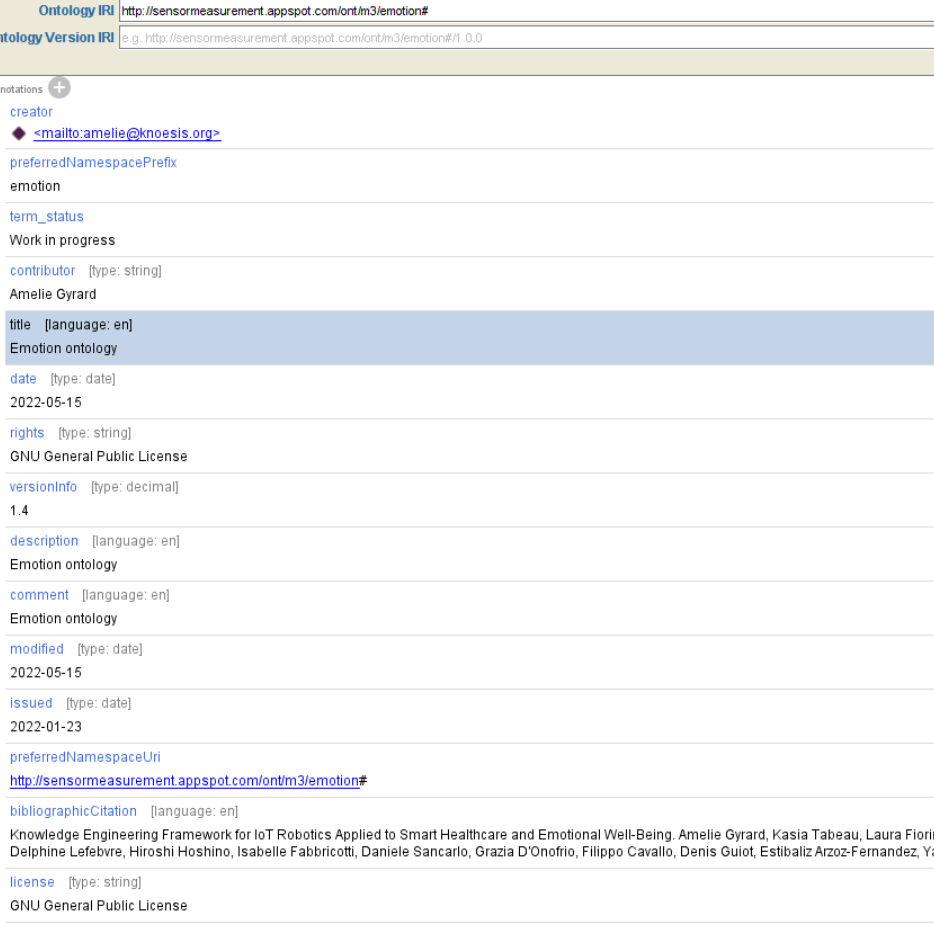
Figure 8. Ontology metadata of our emotion ontology under the Protege Ontology